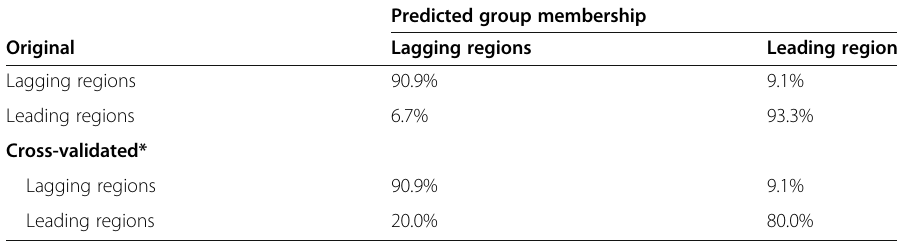
Table 8 Polar extremes approach: classification